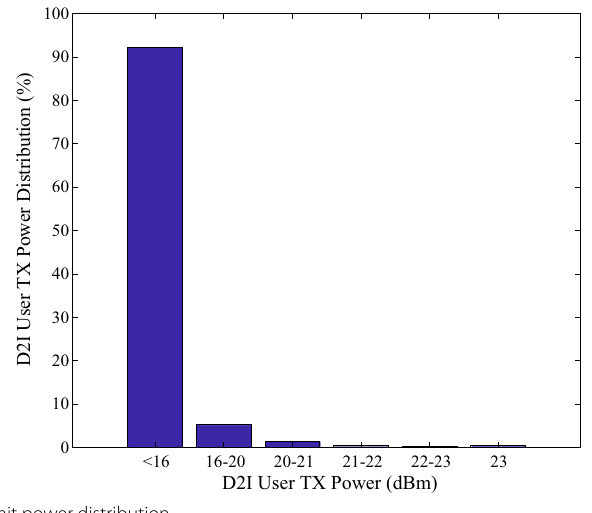
Fig. 8 D2I transmit power distribution